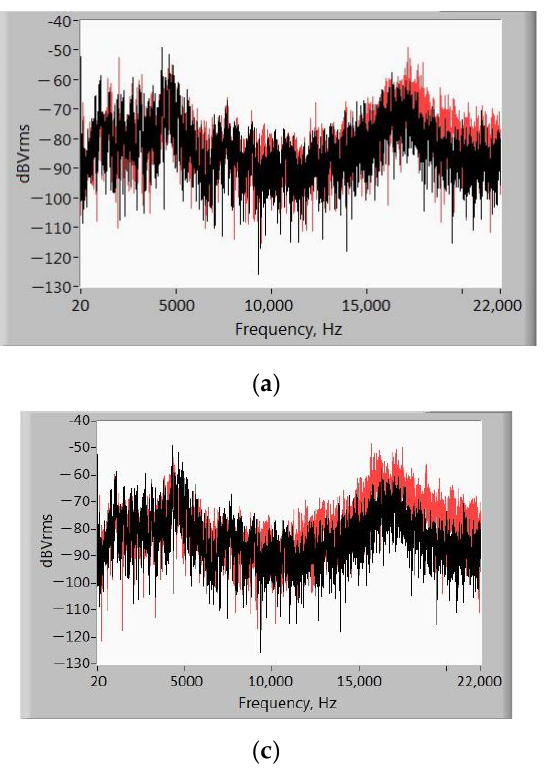
sults are shown in Figure 14. Figure 12. Correlation coefficients of acoustic spectra. Figure 12. Correlation coefficients of acoustic spectra.